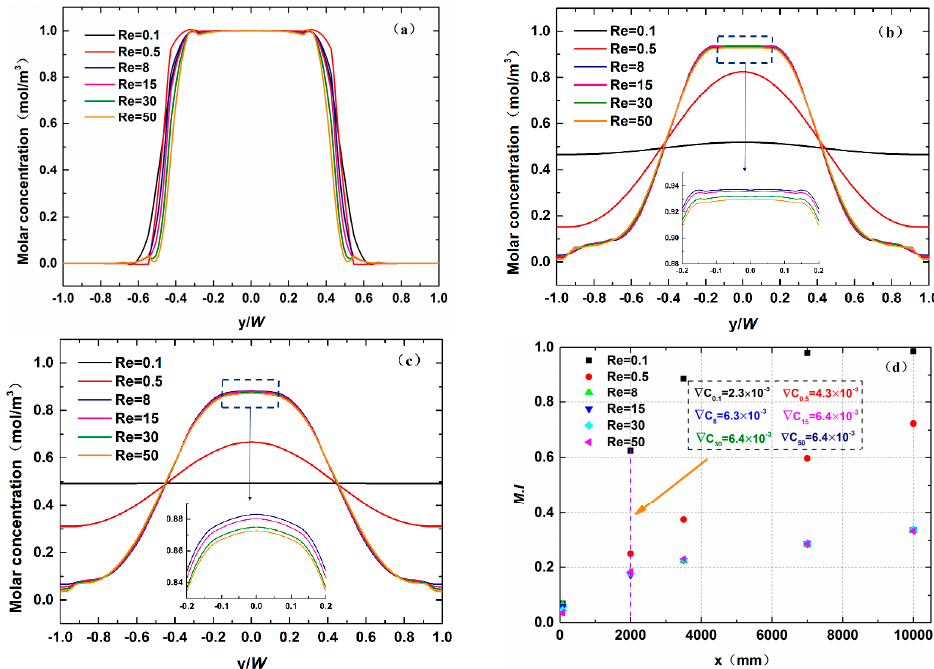
Figure 7. The variations of molar concentration at different cross-sectional positions: ( a ) x = 75 µ m, ( b ) x = 5075 µ m and ( c ) x = 10,075 µ m. ( d ) The performance of mixer at different Re values.